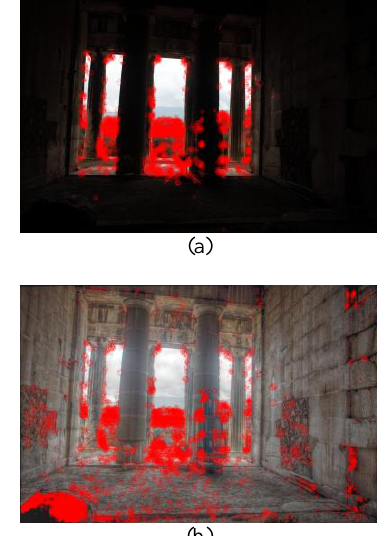
Figure 5: Features detected with ORB (a) on the SDR image (8144 points) and (b) on the HDR image (20000 points).